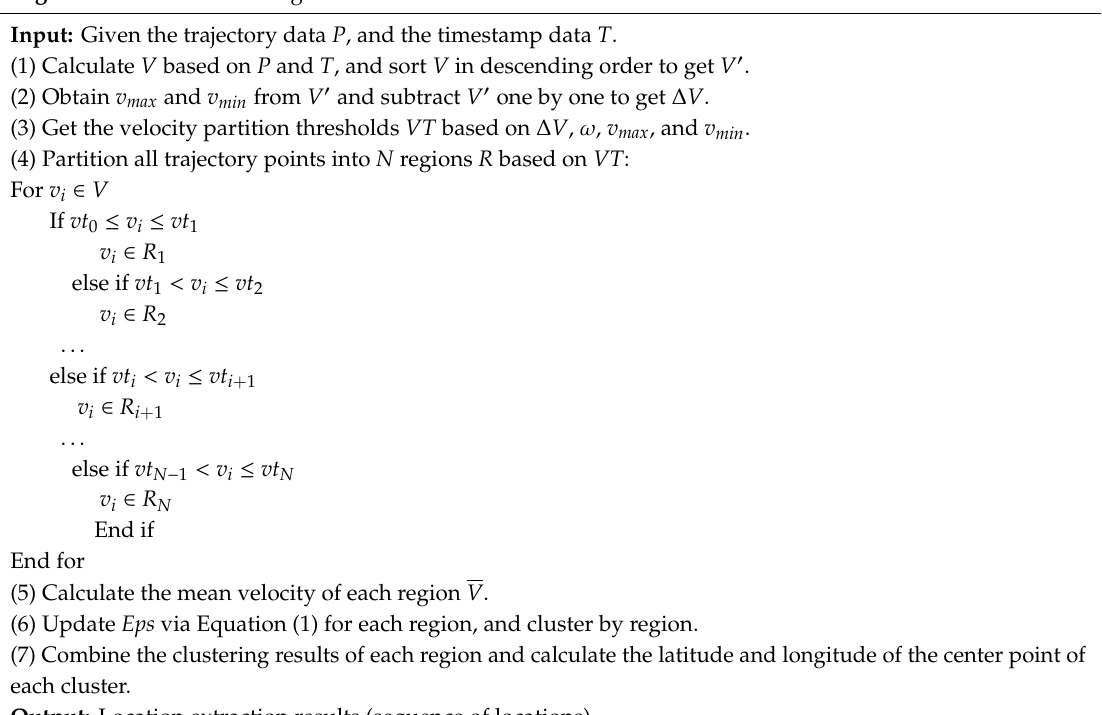
Algorithm 1: D-DBSCAN algorithm for location